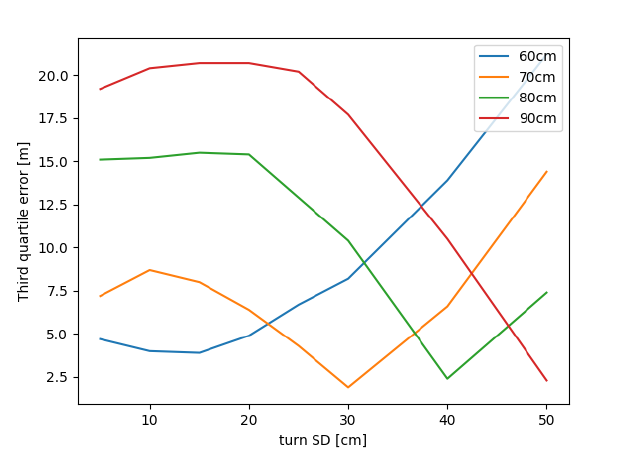
Figure 10. Third quartile of errors for four different step lengths and five turn standard deviations based on T04 logfile with the fine mask GF and step SD = 15.